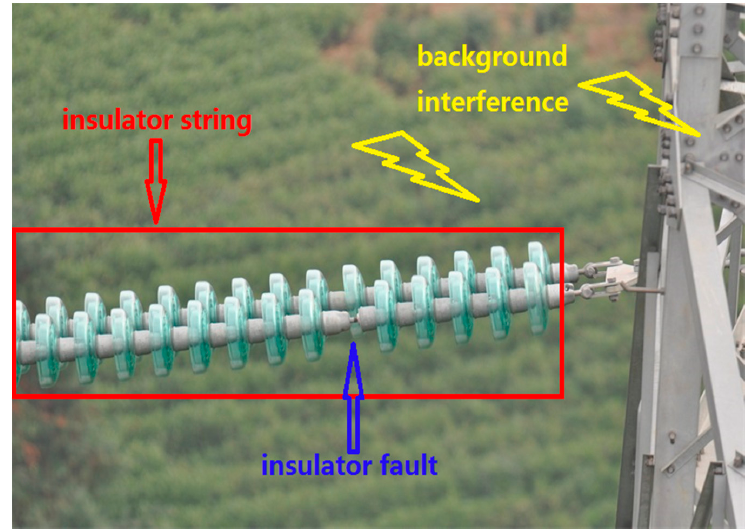
Figure 1. Insulator string (Red color) is composed of evenly spaced insulators, and it will have insulator fault (Blue color) after running for a period of time. At present, an important reason for the low effectiveness of insulator detection and insulator fault detection is the complex background interference (Yellow color) in the aerial image.